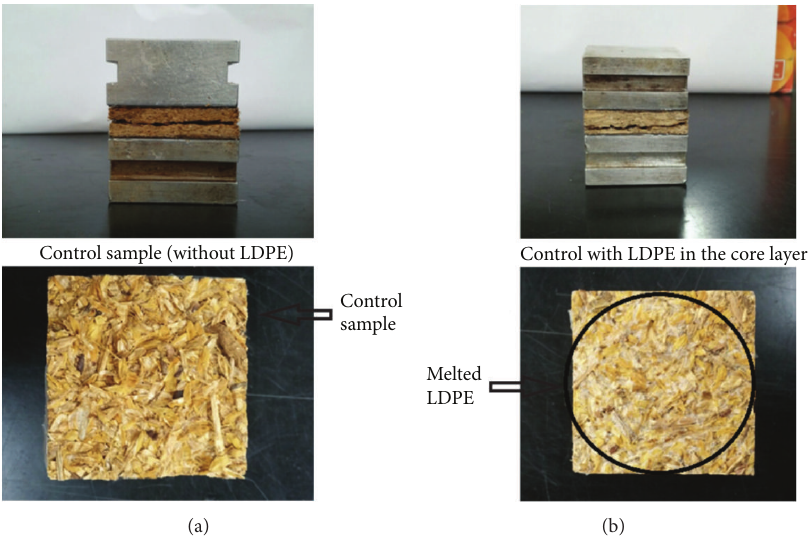
Figure 5: Fracture modes and fracture surface of the IB test samples without LDPE (a) and with LDPE (b) [18].